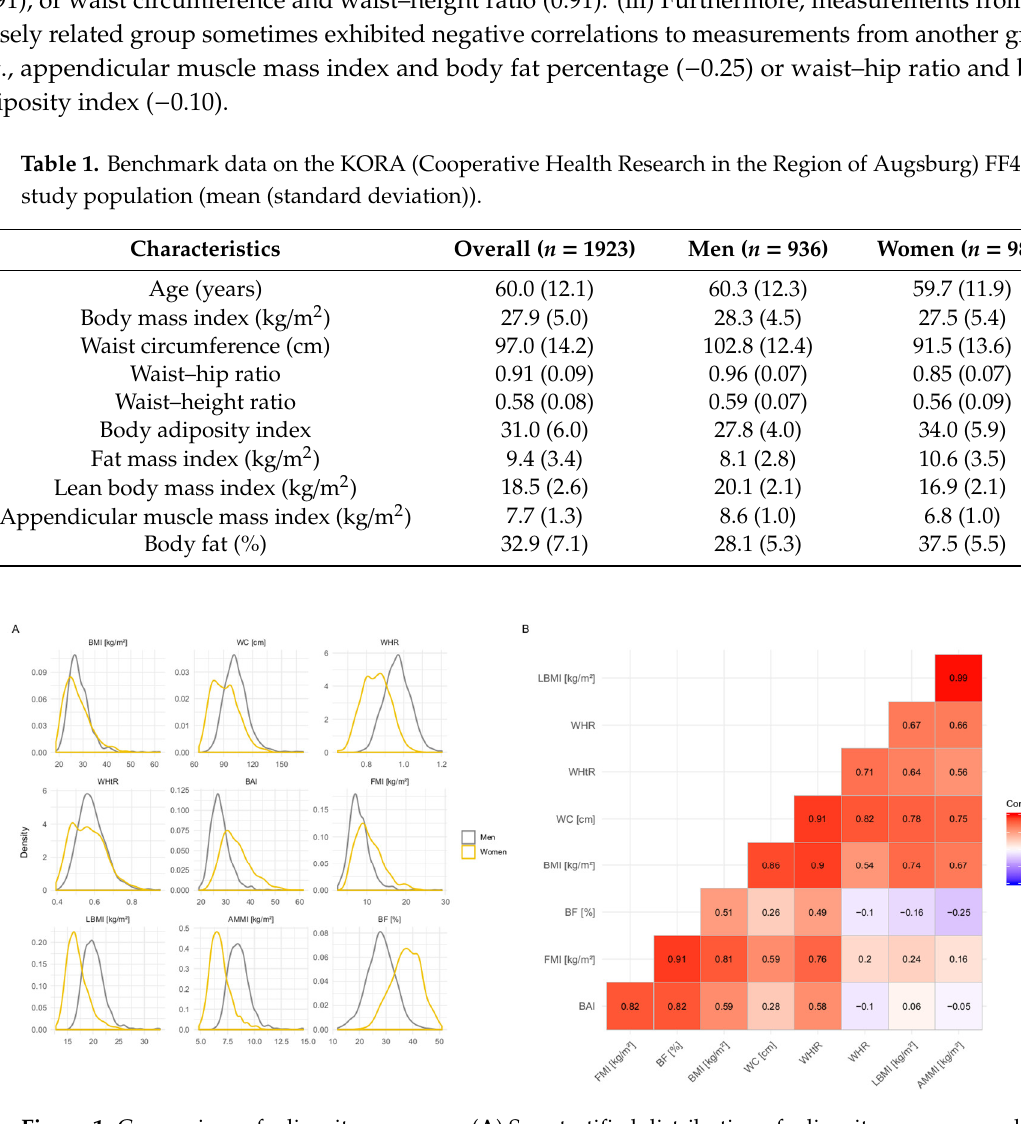
Figure 1. Comparison of adiposity measures: ( A ) Sex-stratified distribution of adiposity measures and ( B ) Spearman correlation in study population ( n = 1923). Adiposity measurements were z-transformed (mean = 0, standard deviation = 1). AMMI: appendicular muscle mass index; BAI: body adiposity index; BF (%): body fat percentage; BMI: body mass index; FMI: fat mass index; LBMI: lean body mass index; WC: waist circumference; WHR: waist–hip ratio; WHtR: waist–height ratio.